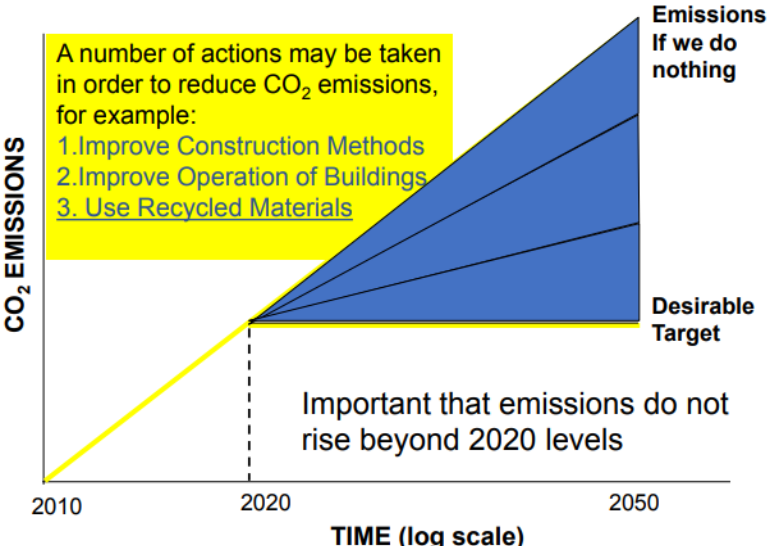
Figure 4. Expected reduction on the carbon footprint globally [34,36,37].